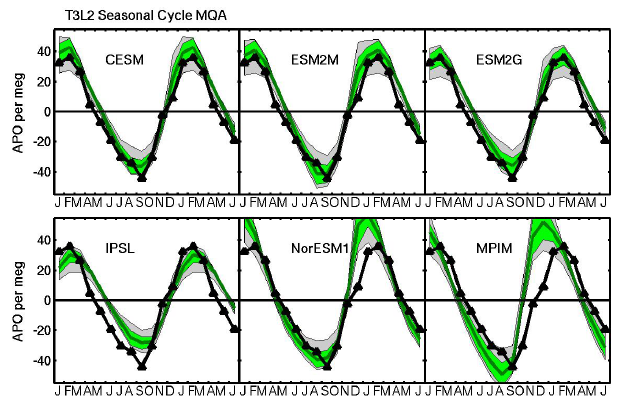
Figure 2e. Results at Alert, Canada (82.5 ◦ N, 62.5 ◦ W), compared to SIO